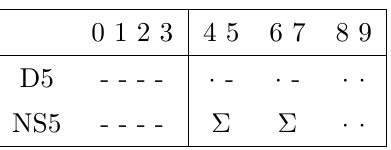
Table 1. D5-branes and smeared NS5-branes are T-dual to D3-branes at CY threefold singularity.